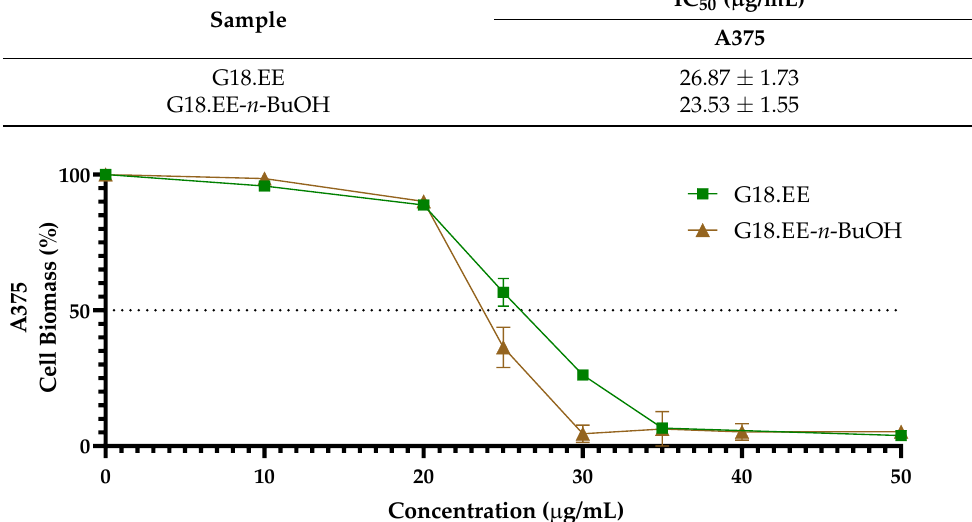
Figure 1. Effect of G18.EE and G18.EE- n -BuOH on total cell biomass of A375 melanoma cell. Cells were treated with a range of concentrations (10 to 50 µg/mL) of G18.EE and G18.EE- n -BuOH for 72 h to determine the IC 50 concentrations. Data were normalized for total biomass. Results are presented as mean ± SD (n ≥ 3).